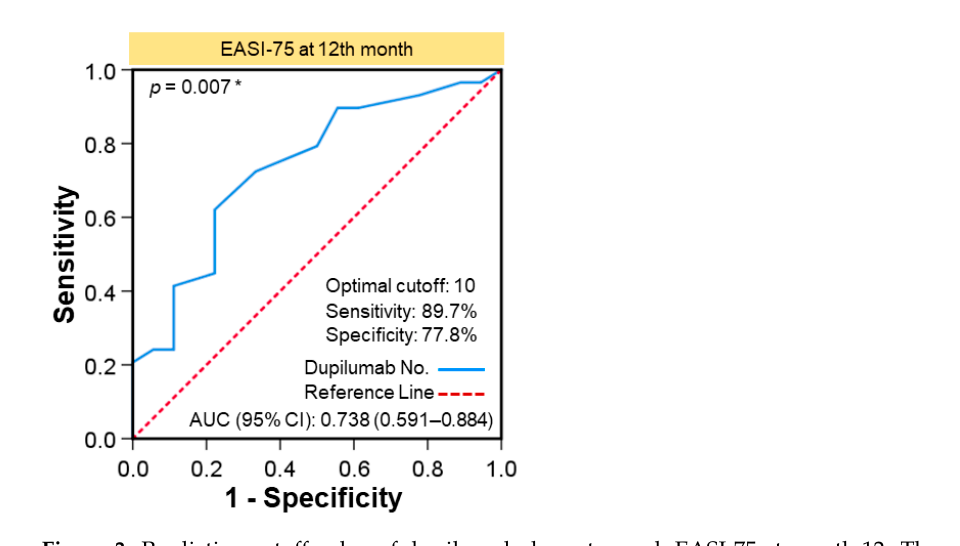
Figure 3. Predictive cutoff value of dupilumab doses to reach EASI-75 at month 12. The optimal differential predictive cutoff value of number of dupilumab doses was 10, as shown by ROC analysis, with AUC of 0.738, sensitivity of 89.7%, and specificity of 77.8% ( p = 0.007). * p < 0.05.